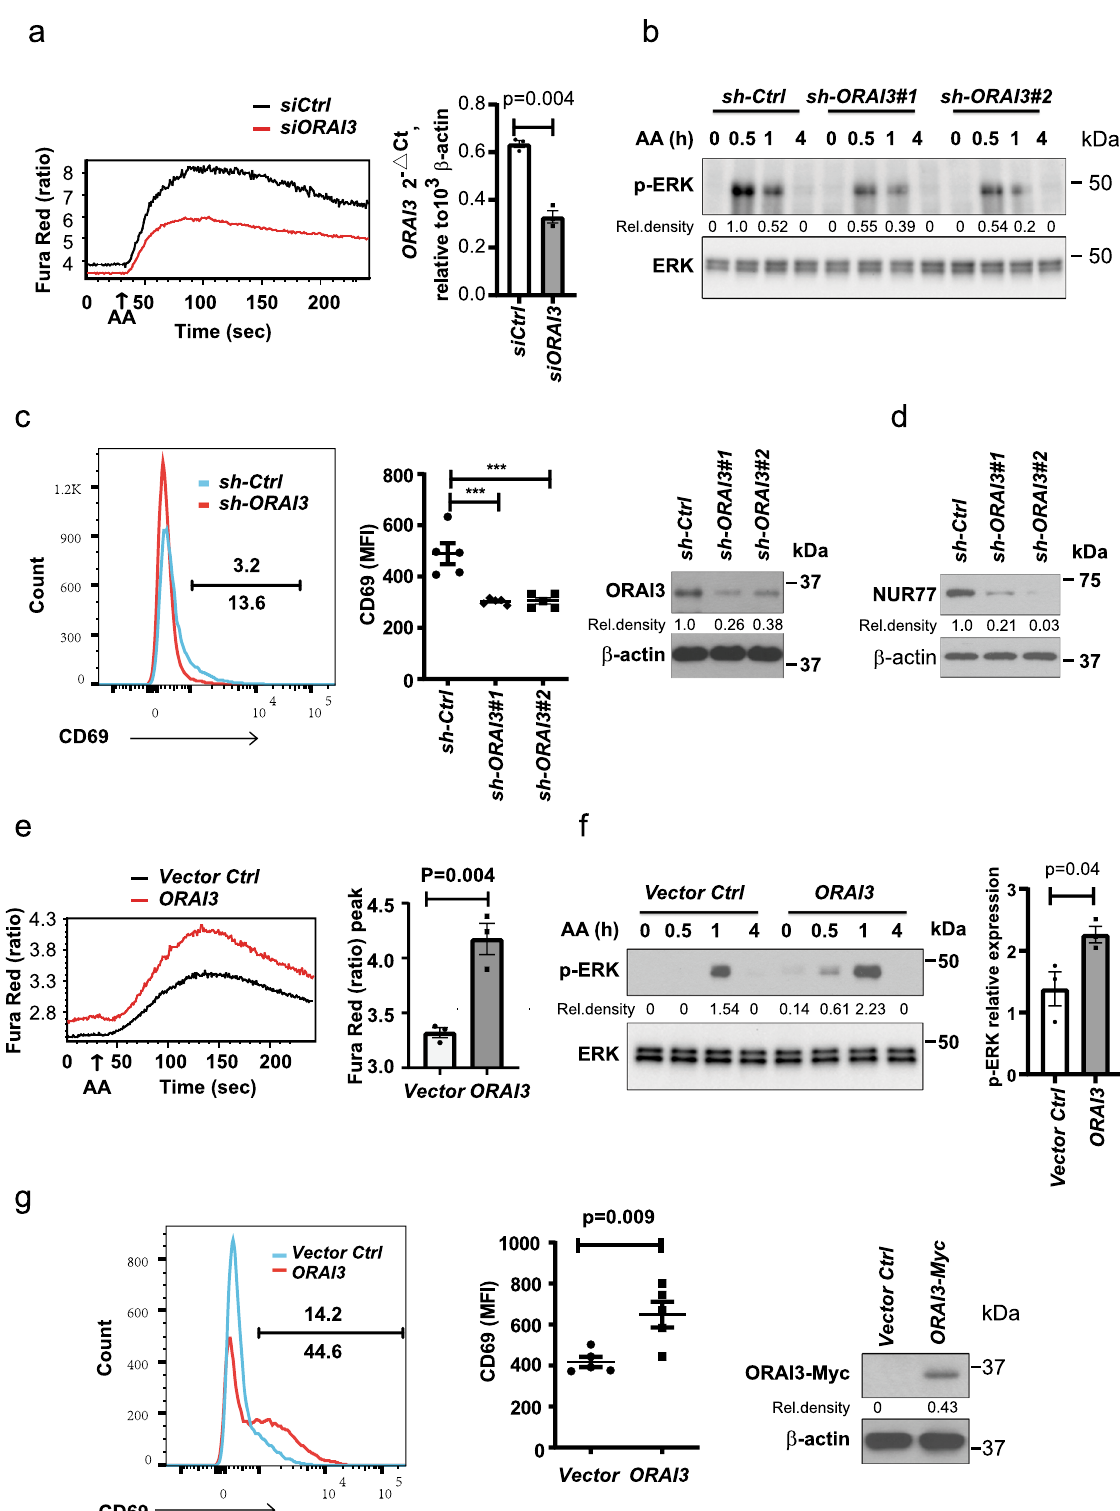
memory (CM) CD4 + T cells from nine HCs, 15 to 17 patients with RA, and 10 PsA patients. A large region including the TSS was accessible in naive and less so in CM CD4 + T cells from HC. Accessibility was signi fi cantly reduced for naive and CM CD4 + T cells from both RA and PsA patients compared to HC (Fig. 8a). Several additional more distal gene regulatory regions of IKZF1 were also more accessible in HC T cells. IKZF1 transcription was